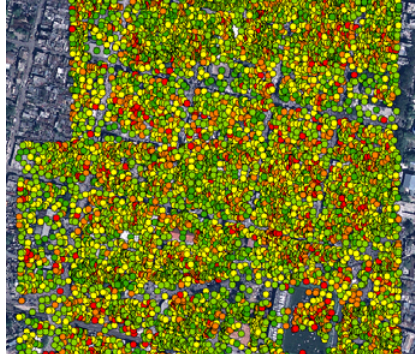
Figure 3 Overview classification result showing centre points of segments coloured by number of counts (green = 0/1, yellow = 2, orange = 3, red =4/5.